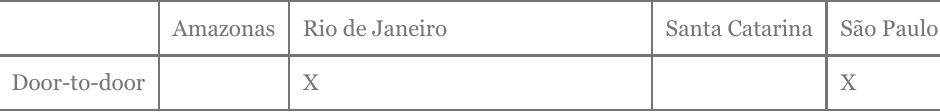
Table 3. 2014 Brazilian GOTV experiments by